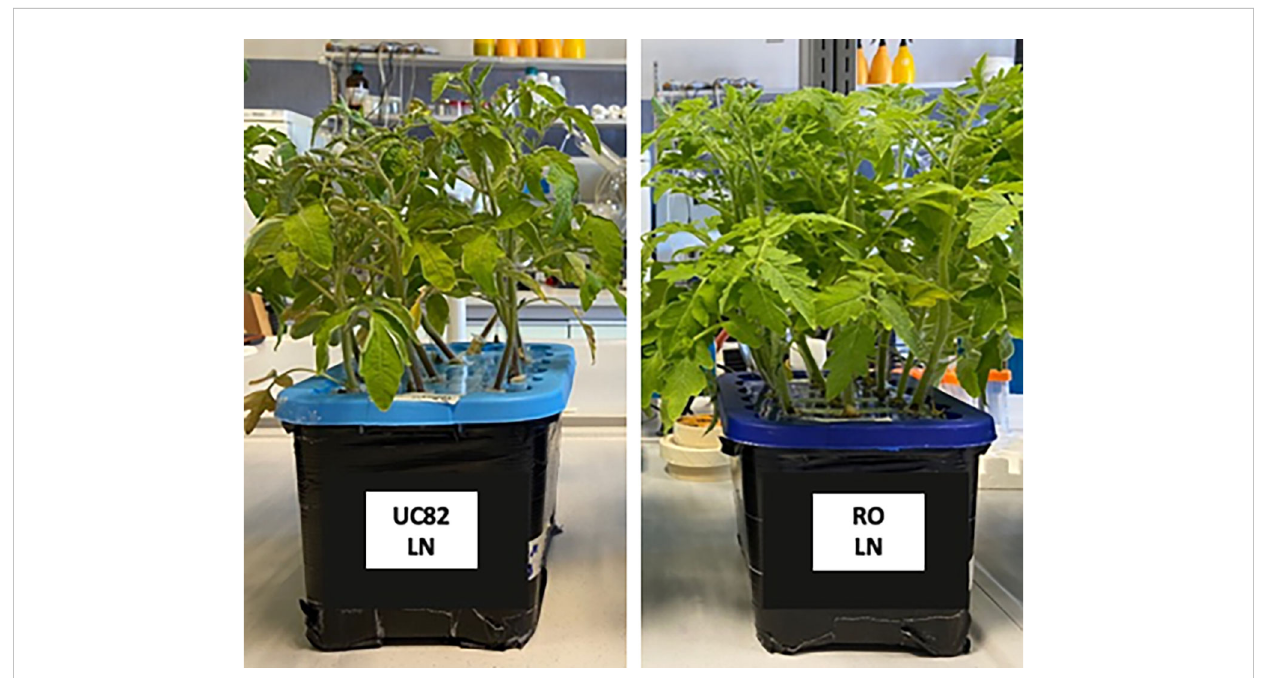
FIGURE 1 Tomato genotypes UC82 and Regina Ostuni (RO) grown in hydroponic systems at low N (LN)